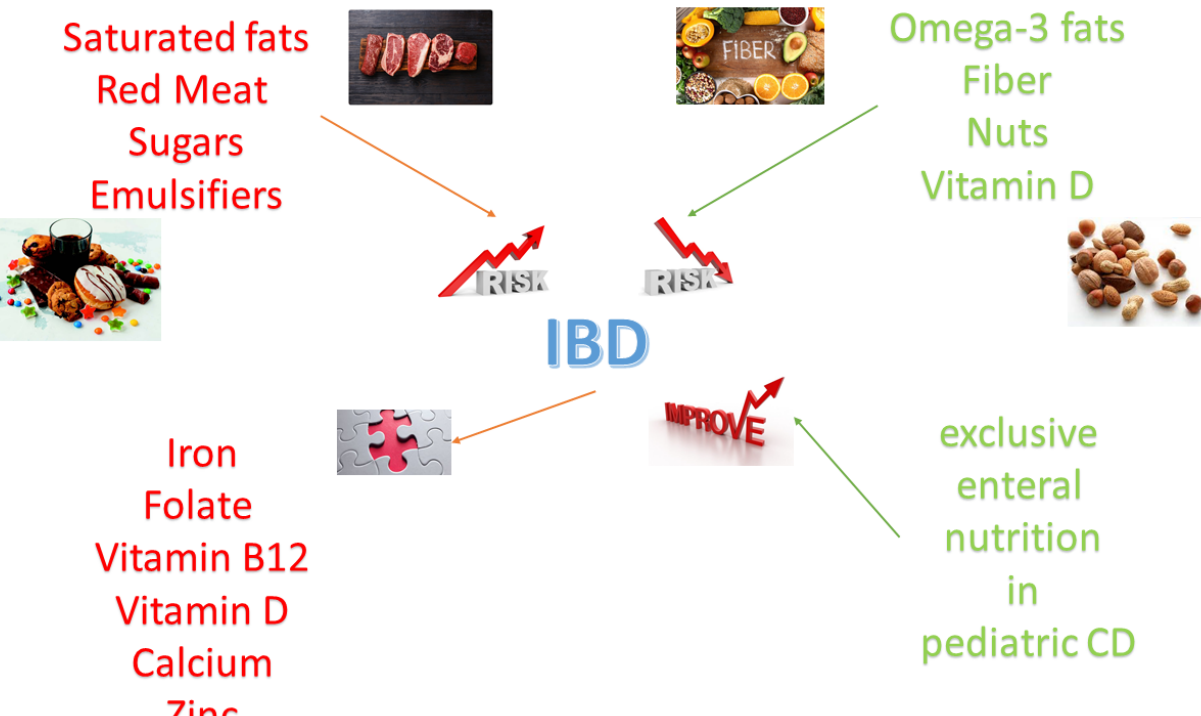
Figure 1. Pro-inflammatory and anti-inflammatory nutrients influence the risk of inflammatory bowel disease (IBD). Micronutrient deficiency is an important consequence of inflammatory bowel disease. Dietetic interventions, in particular exclusive enteral nutrition in children with Crohn’s disease, are effective in inducing remission.